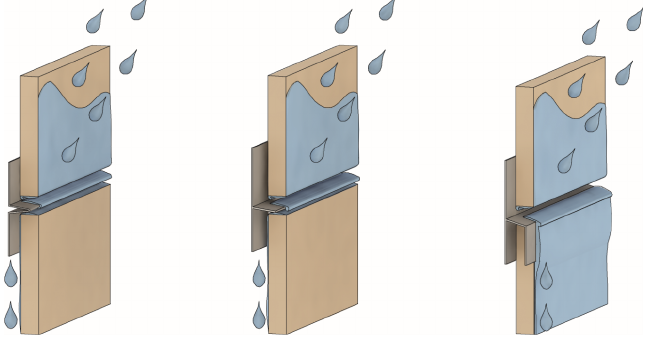
Figure 14. Assumed water intrusion when profiles centered in the